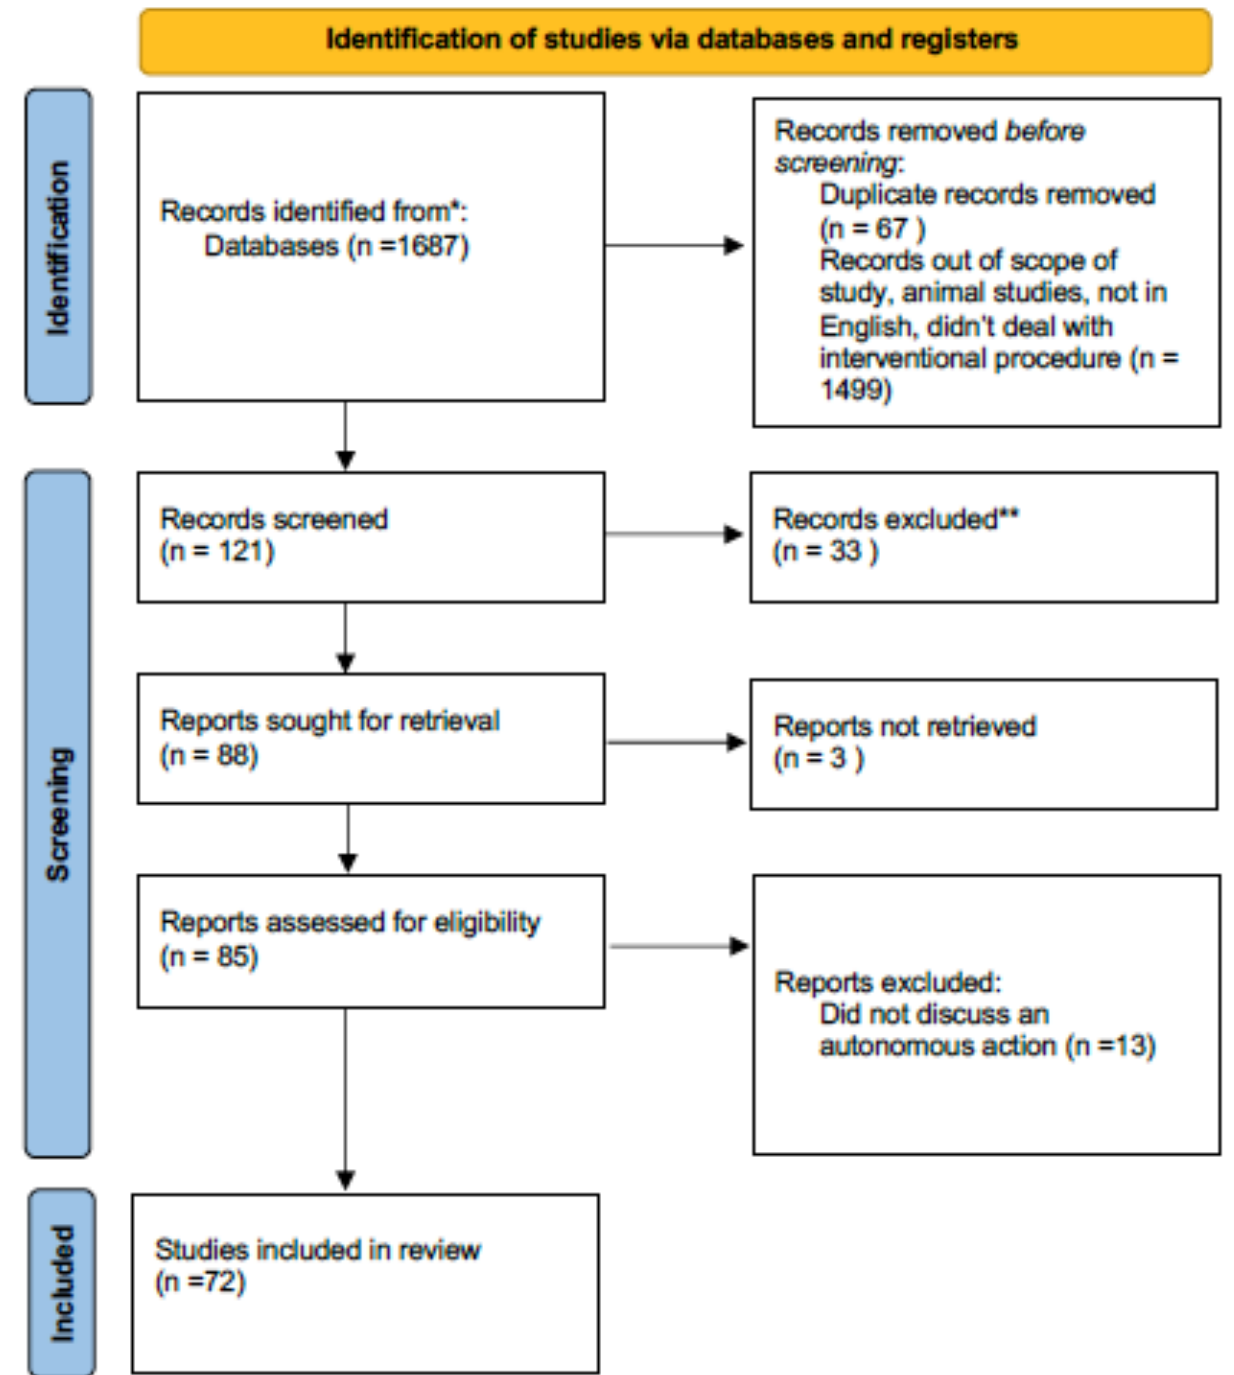
Figure 1. PRISMA flow diagram for this review article. * Pubmed ** did not discuss autonomous actions in surgery.